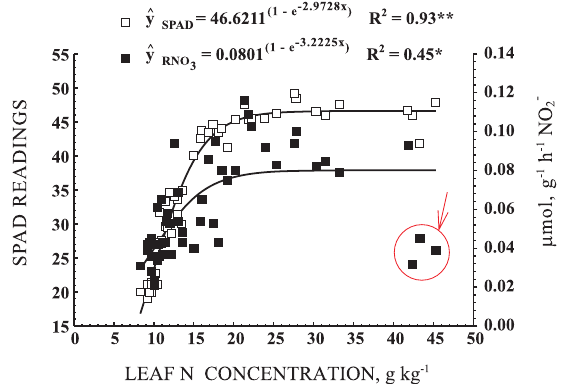
Figure 5. Relationship among SPAD readings ( ), leaf N concentration and nitrate reductase activity ( ) taken on the newly expanded lamina leaf (NL), in the first growth. The three plots (arrow) are related to N and K combination of 429N/ 19.5K.